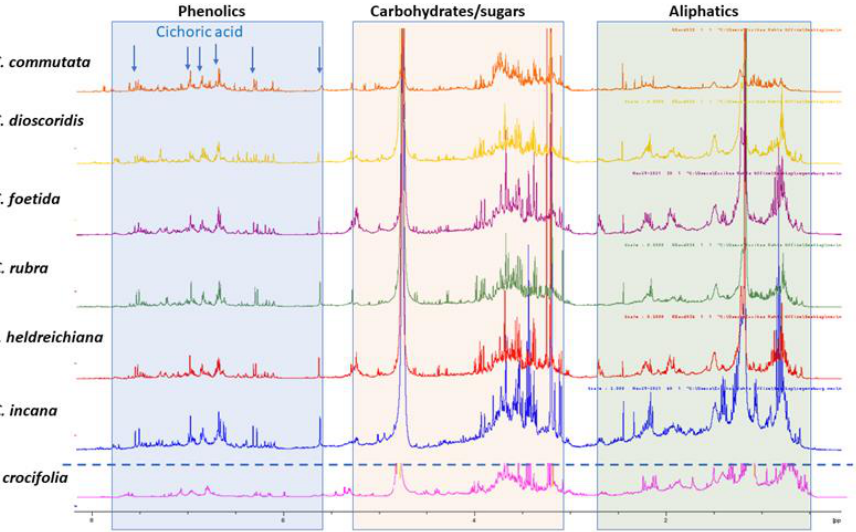
Figure 1. 1 H NMR comparison of plant n-butanol extracts: Crepiscommutata (orange), C. dioscoridis (yellow), C. foetida (purple), C. rubra (green), C. heldreichiana (red), C. incana (blue), Phitosiacrocifolia (pink) in CD 3 OD; diagnostic signals for cichoric acid are indicated with blue arrows.